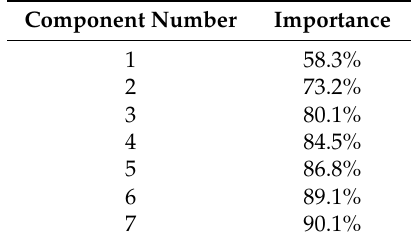
Table 1. Importance of Each Component after Orthogonal